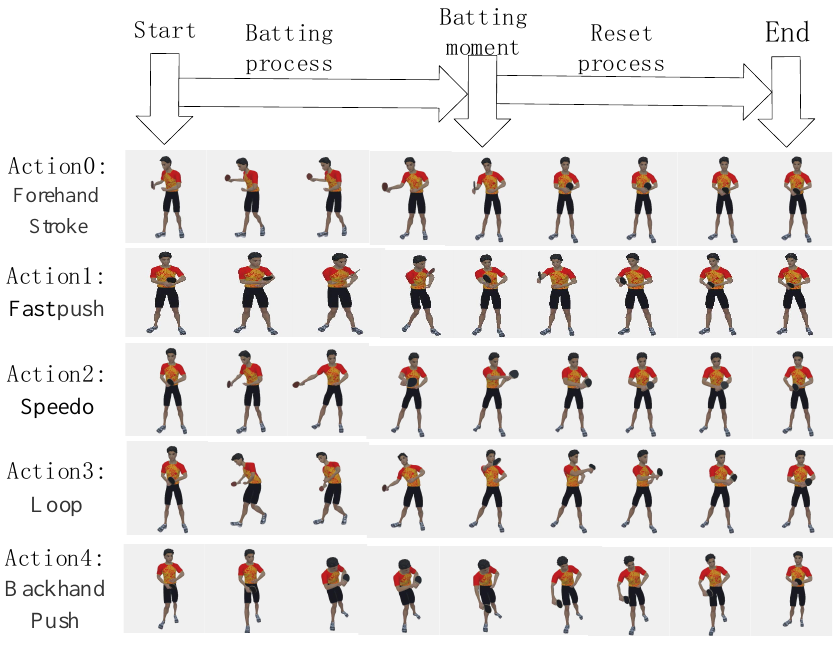
Figure 9. A simple schematic diagram of the five-table tennis hitting processes. We used the data of person 0 and person 1 as major-test sets. After mixing the data of the remaining ten subjects, they were randomly divided into training sets and validation sets. The data distribution is shown in Table 4. Table 4. Experimental data set.